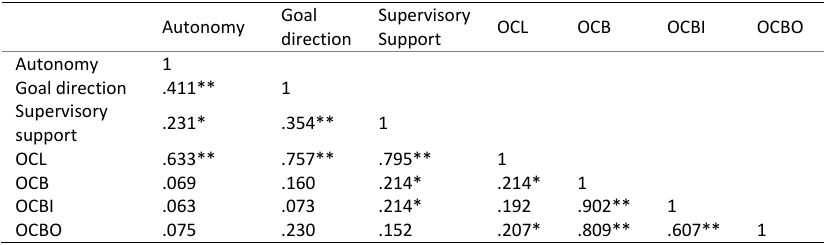
Table 4: Correlation Matrix for all constructs Table 4. Correlation Matrix for all